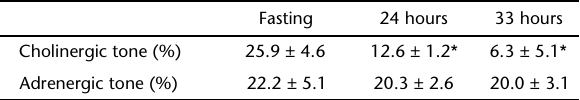
Table 2. Cholinergic and adrenergic tones on the heart during fasting and digestion. Asterisk shows significantly differences from fasting values.